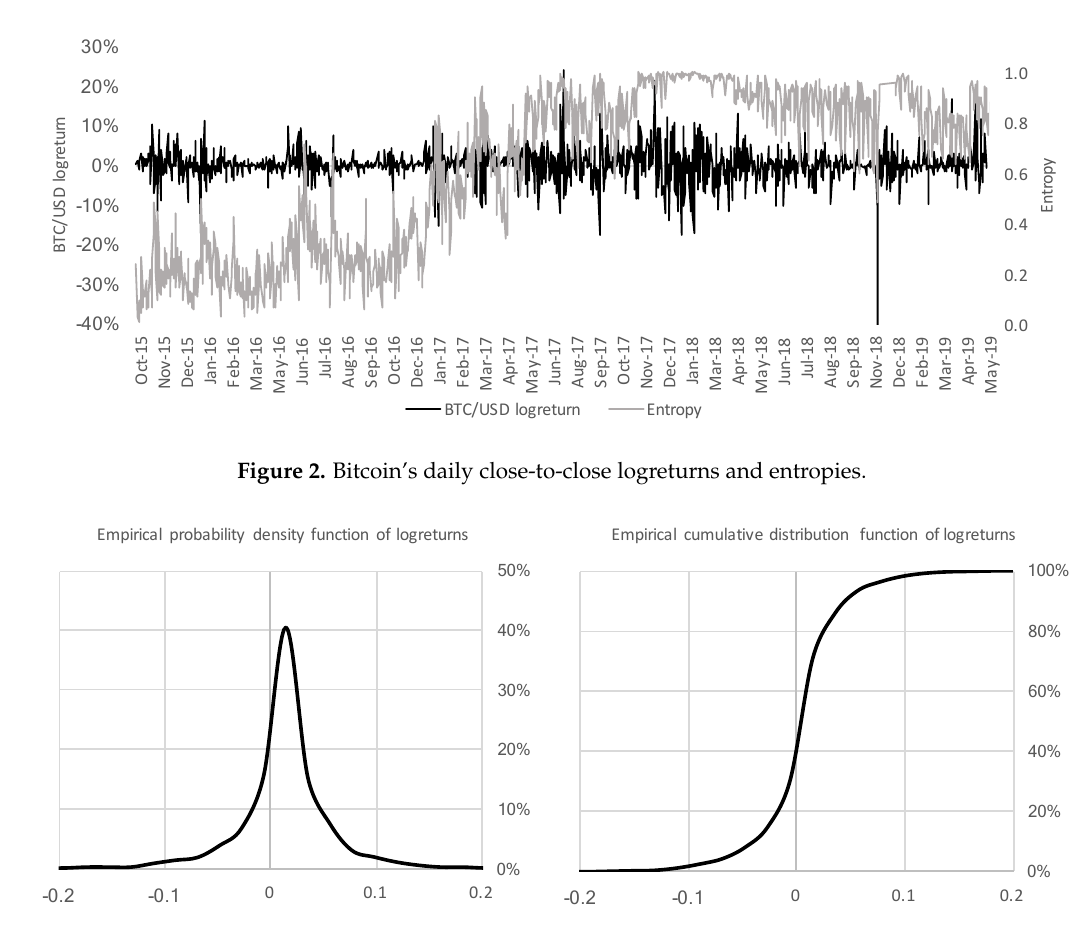
Figure 3. The empirical probability density function and the empirical cumulative distribution distribution function of the Bitcoin’s daily close-to-close